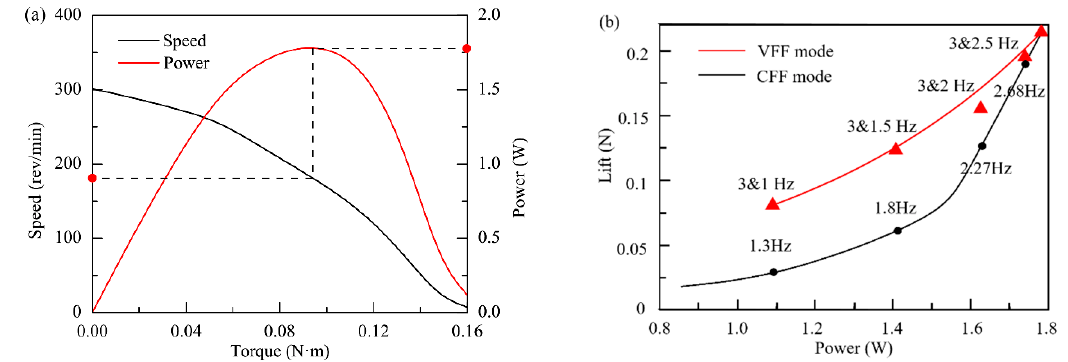
Figure 17. ( a ) Mechanical output curves of motor; ( b ) the relationship between lift and output power.